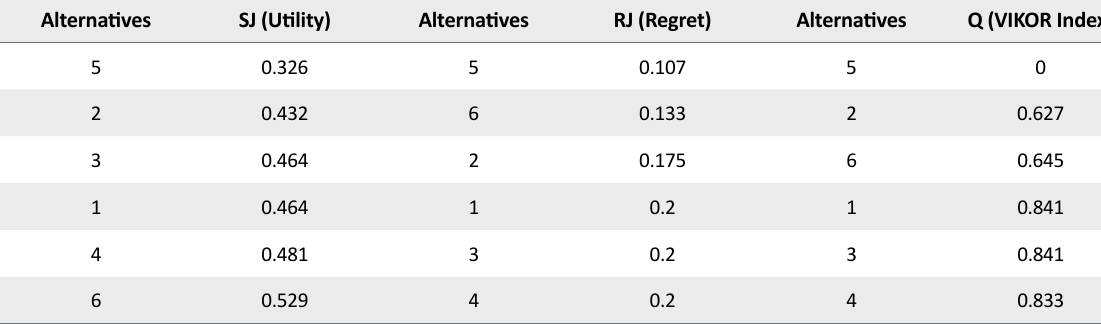
Table 5. Final ranking and selection of the best alternative using the fuzzy VIKOR method Alternatives SJ (Utility) Alternatives RJ (Regret) Alternatives